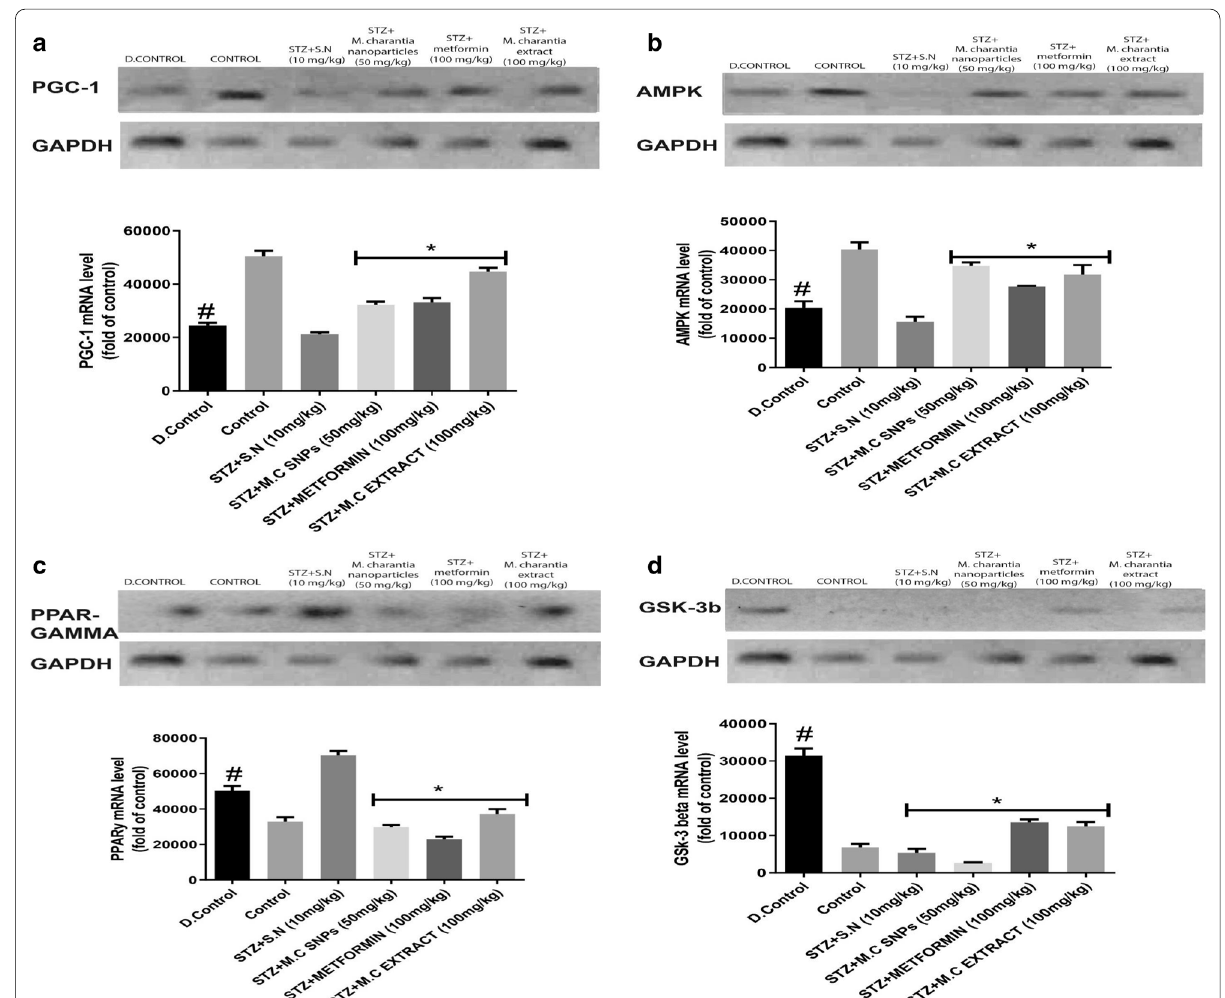
Fig. 2 a Snapshot representation of the densitometric evaluation of agarose gel electrophoresis of the reverse transcriptase polymerase chain reaction (RT-PCR) analysis of pgc-1α expression. *represent statistical difference to control ( p < 0.05) while # represent statistical difference to Diabetic control ( p < 0.05). b Snapshot representation of the densitometric evaluation of agarose gel electrophoresis of the reverse transcriptase polymerase chain reaction (RT-PCR) analysis of AMPK expression. *represent statistical difference to control ( p < 0.05) while # represent statistical difference to Diabetic control ( p < 0.05). c Snapshot representation of the densitometric evaluation of agarose gel electrophoresis of the reverse transcriptase polymerase chain reaction (RT-PCR) analysis of PPAR- ϒ expression. *represent statistical difference to control ( p < 0.05) while # represent statistical difference to Diabetic control ( p < 0.05). d Snapshot representation of the densitometric evaluation of agarose gel electrophoresis of the reverse transcriptase polymerase chain reaction (RT-PCR) analysis of GSK-3β expression. *represent statistical difference to control ( p < 0.05) while # represent statistical difference to Diabetic control ( p <